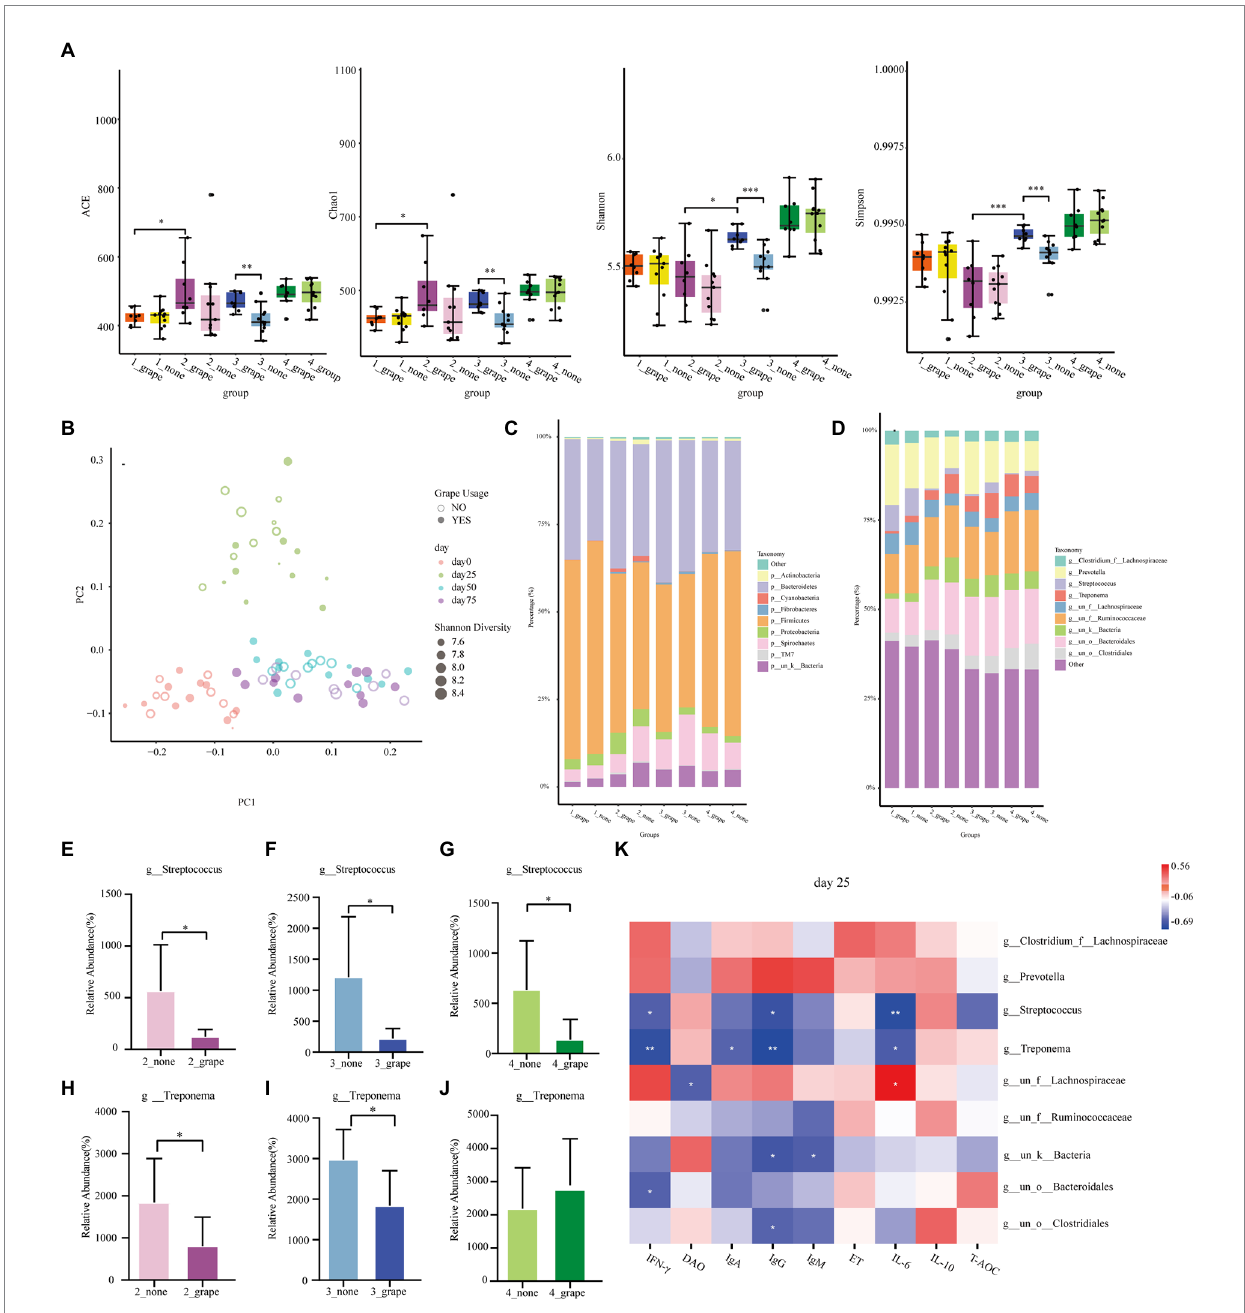
FIGURE 4 Effect of grape pomace diet on the microbial community of finishing pigs. (A) Effect of grape pomace diet on the Chao1, Shannon, ACE, and Simpson index. (B) Analysis of similarities (ANOSIM) between control and treatment groups. (C) The relative abundance of cecal microbial at the phylum level (mean of each group). (D) The relative abundance of cecal microbial at the genus level (mean of each group). Effect of grape pomace diet on the relative abundance of the microbial family g_Streptococcus on (E) day 25, (F) day 50, and (G) day 75. Effect of grape pomace diet on the relative abundance of microbial family g_Treponema on (H) day 25, (I) day 50, and (J) day 75. (K) Heatmap of the significant differences of family correlated with the antioxidant indicators and cytokines levels on day